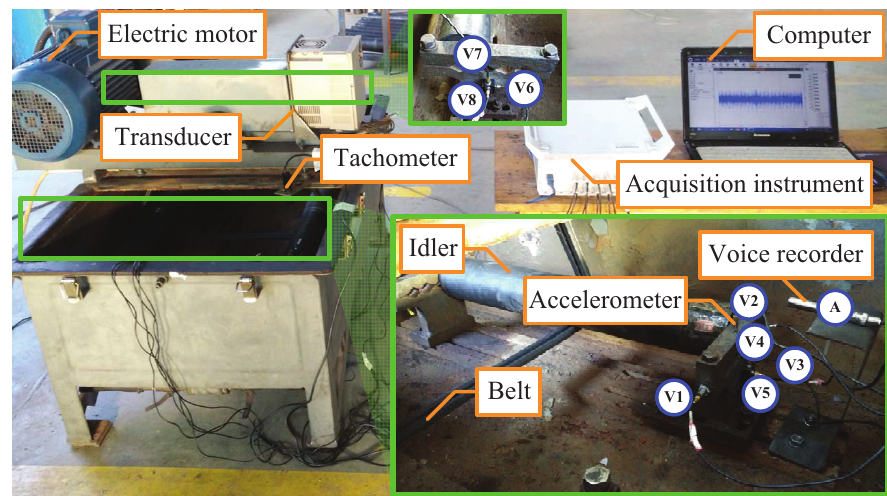
Figure 2. Bearing test platform of the belt conveyor